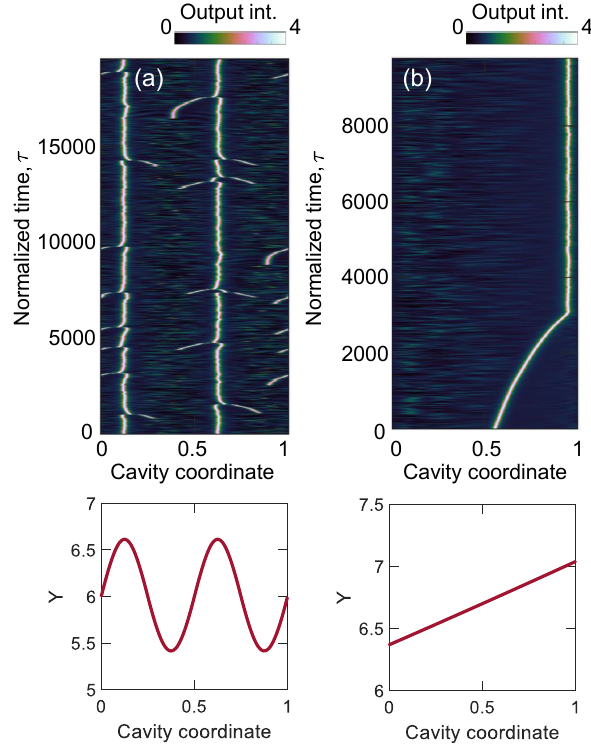
Figure 10: (a) Upper panel: cavity solitons (CSs) are spontaneously excited inside the cavity and follow the positive gradient of the field profile, being trapped at regime on the local maxima. Lower panel: intensity profile of the input field across the cavity. ( Y = 6.0) (b) Upper panel: a CS follows the linear gradient with non-uniform ve- locity. Lower panel: intensity pro fi le of the input fi eld across the cavity ( Y = 6.7).